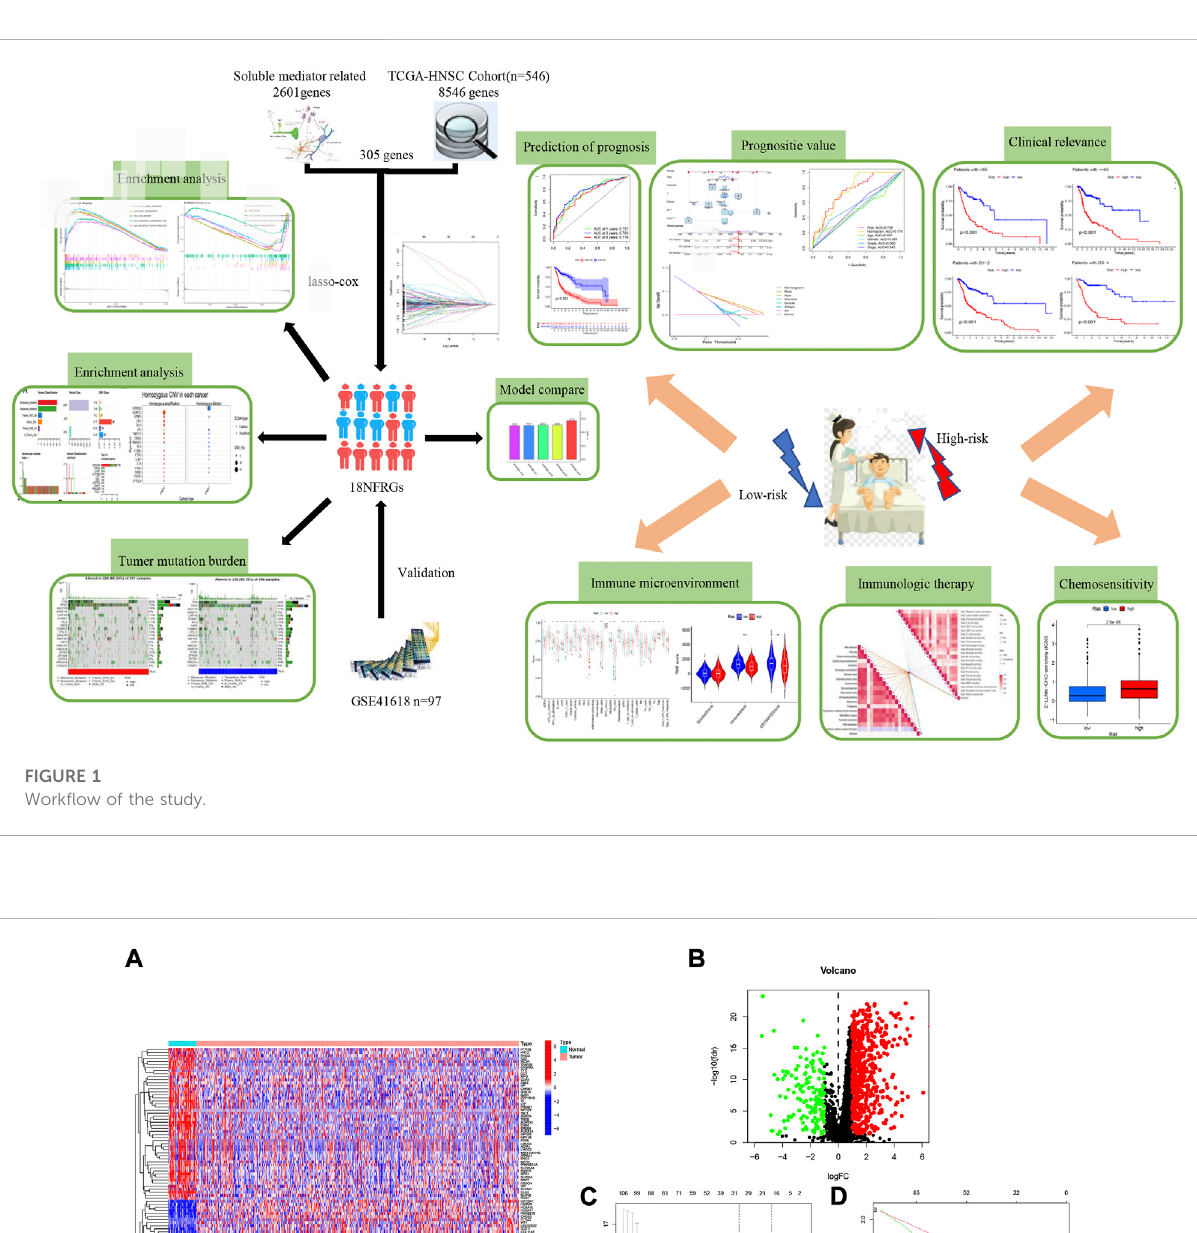
FIGURE 2 Identi fi cationofcandidateNFRGs. (A) HeatmapofthedifferenceinmRNAexpressionbetweentumorsamplesandnormalsamples. (B) Volcano map of NFRGs with differential expression. (C) Adjustment of parameters and (D) cross-validation in the LASSO